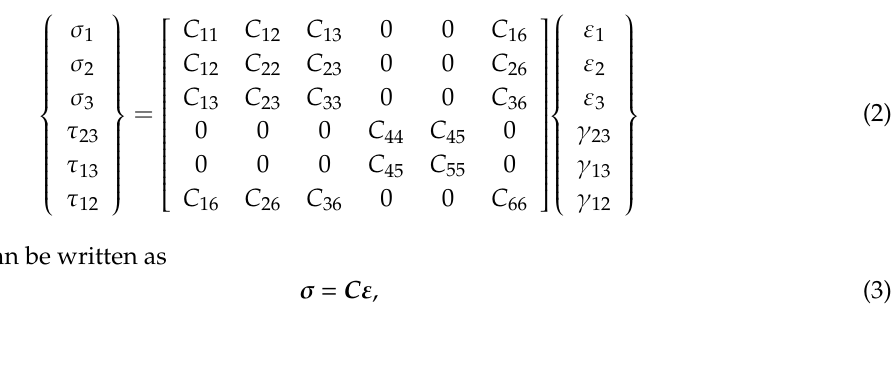
Figure 7. The coordinate system of the composite.